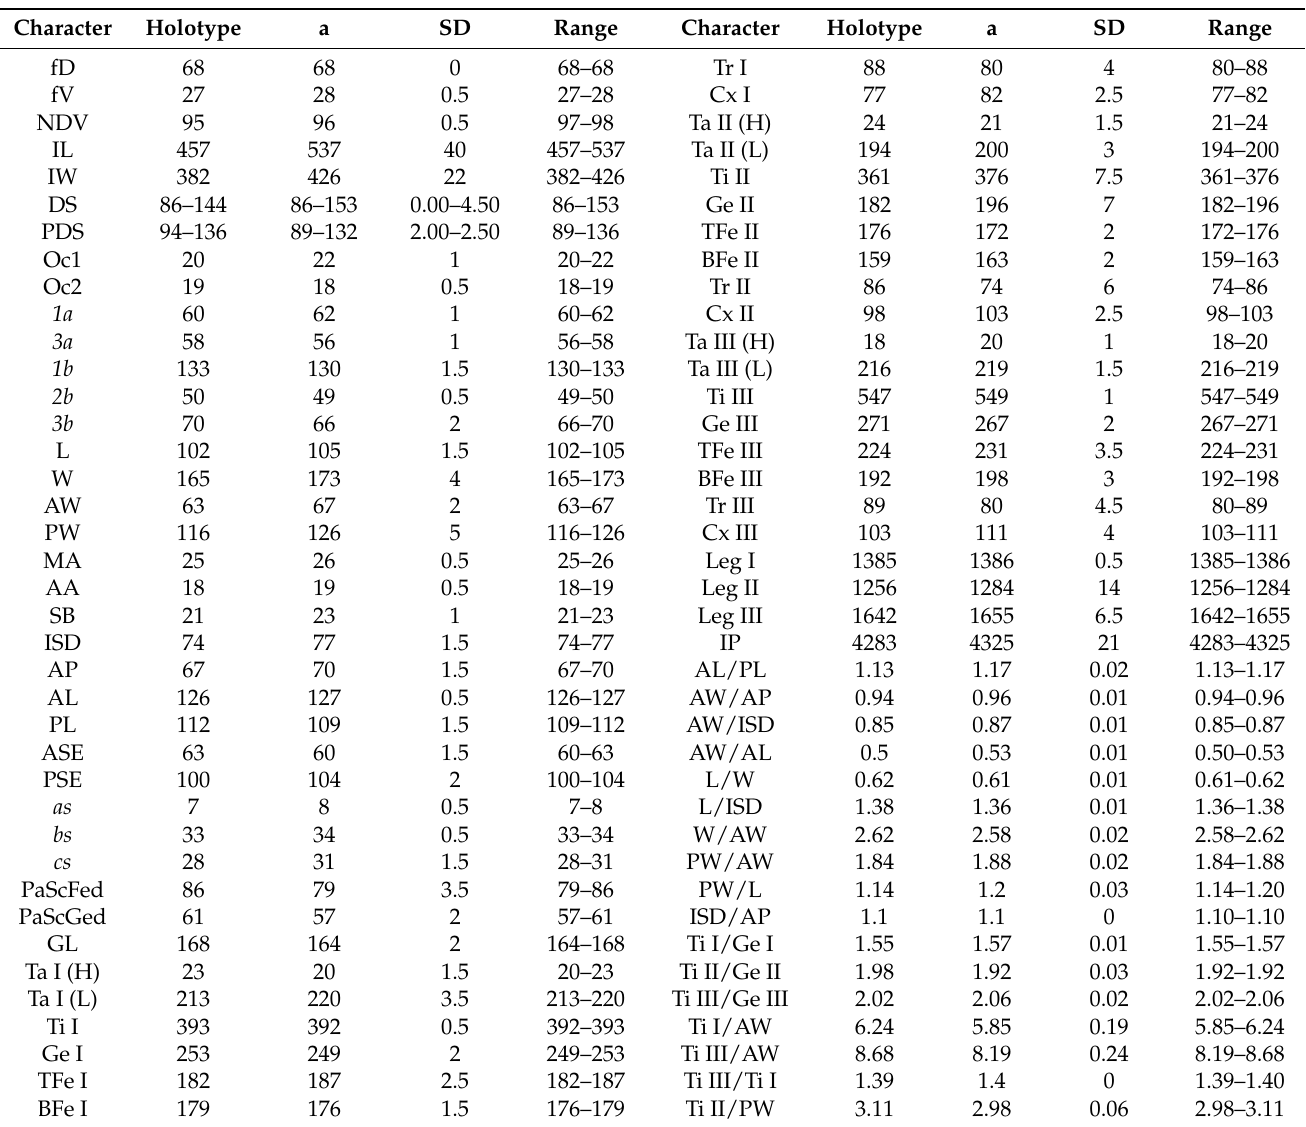
Figure 3. Eatoniana nanlingensis sp. nov. , larva. Photograph. Showing outline of scutum. Table 1. Measurements of Eatoniana nanlingensis sp. nov. (larva, a = paratype).